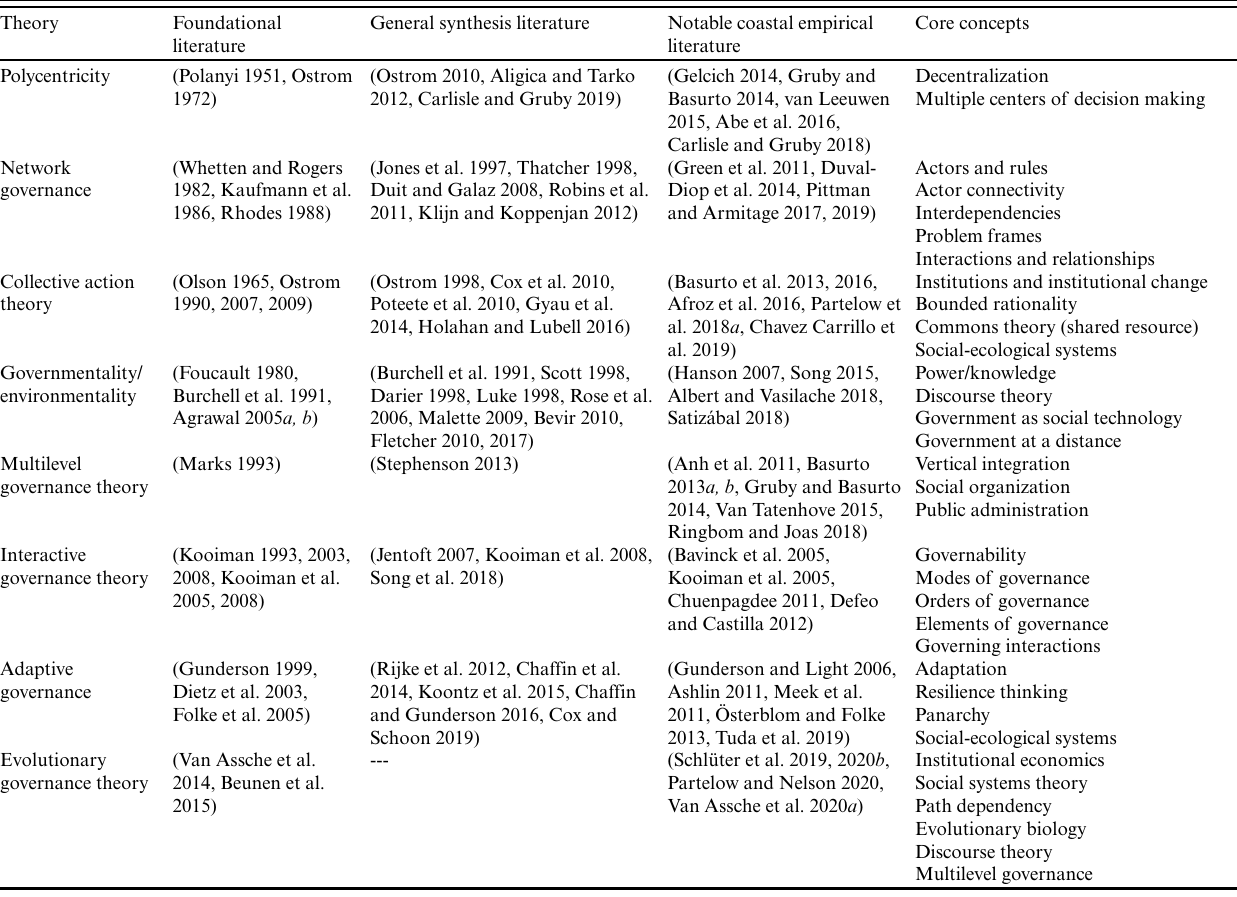
Table 1 . Overview of theoretical literature on natural resource